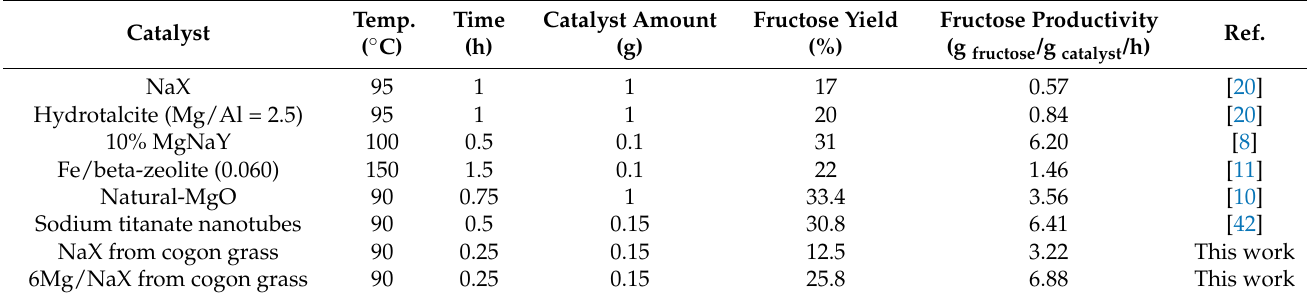
Table 2. Comparison of glucose conversion, fructose yield and selectivity using microwave-assisted catalytic glucose isomerization in the present work to relevant literature. Catalyst